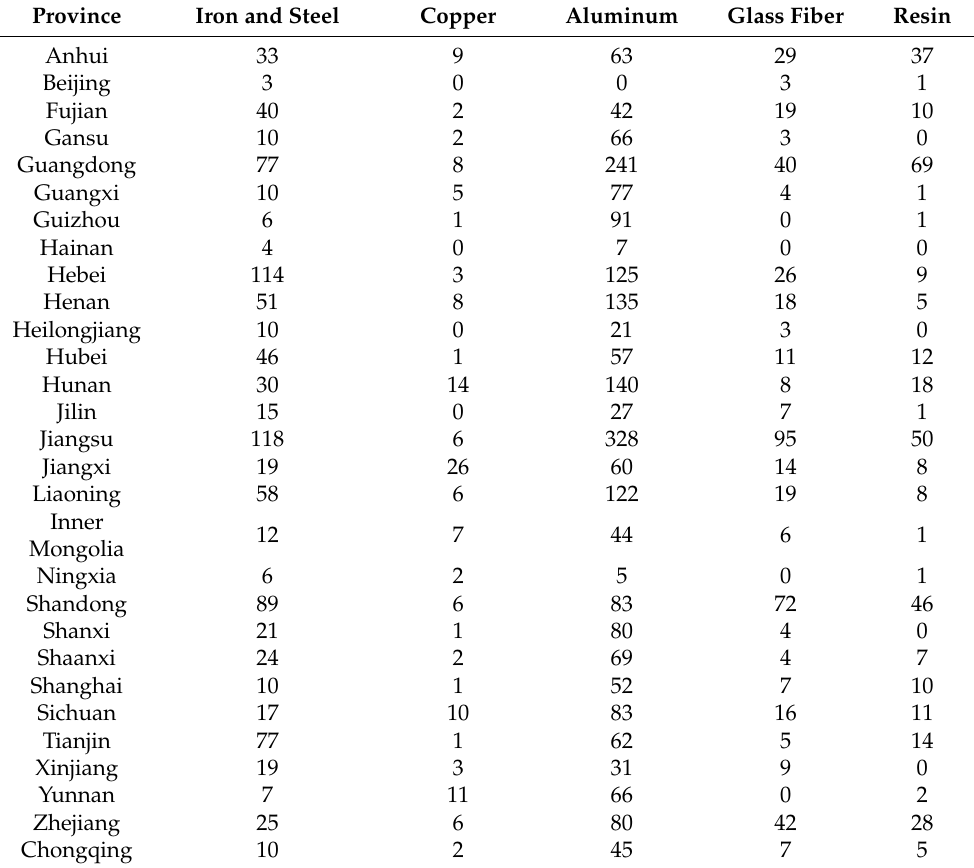
Table 3. The number of enterprises producing main materials of